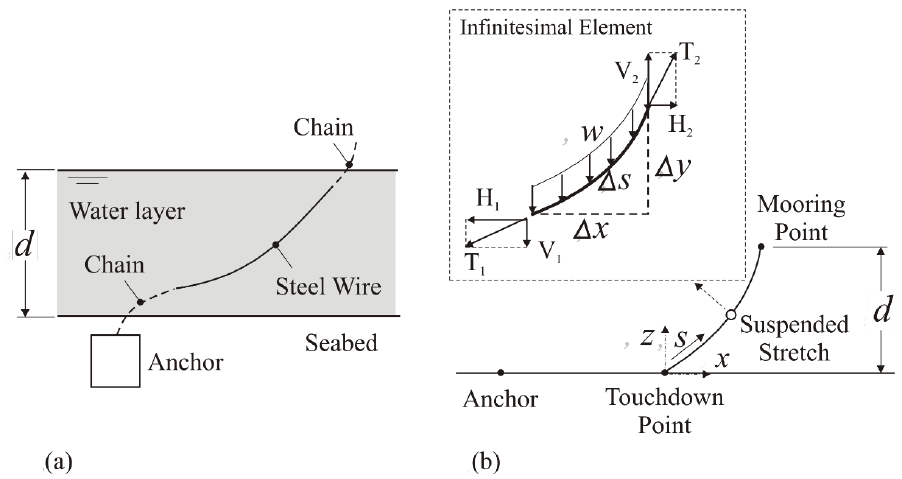
Figure 3. Illustration of the line segments adopted in the present problem and the forces acting in the catenary mooring line’s infinitesimal element: ( a ) global view, ( b ) forces acting in the infinitesimal element of the line.